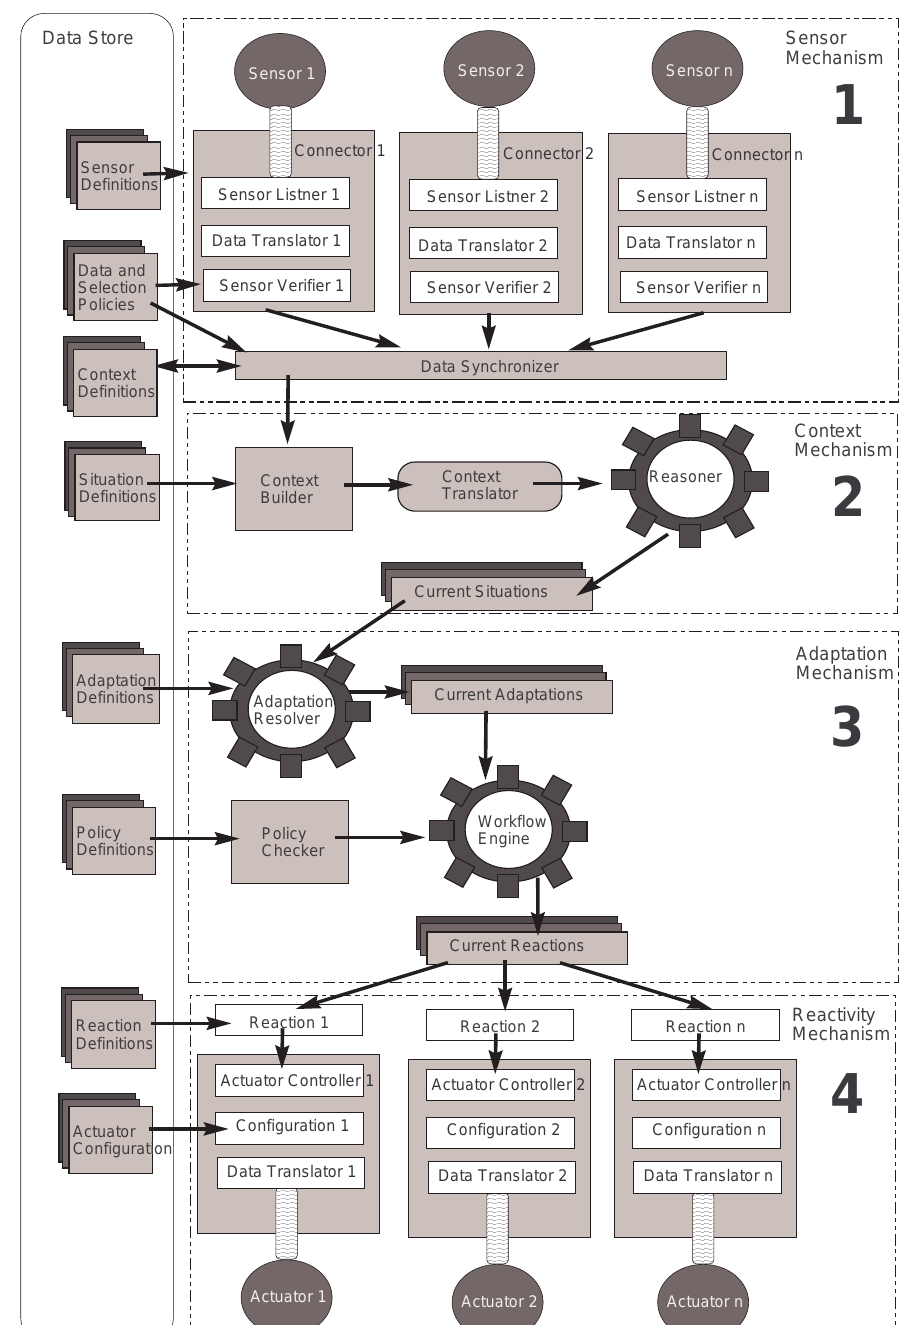
Figure 4. Detailed View of The